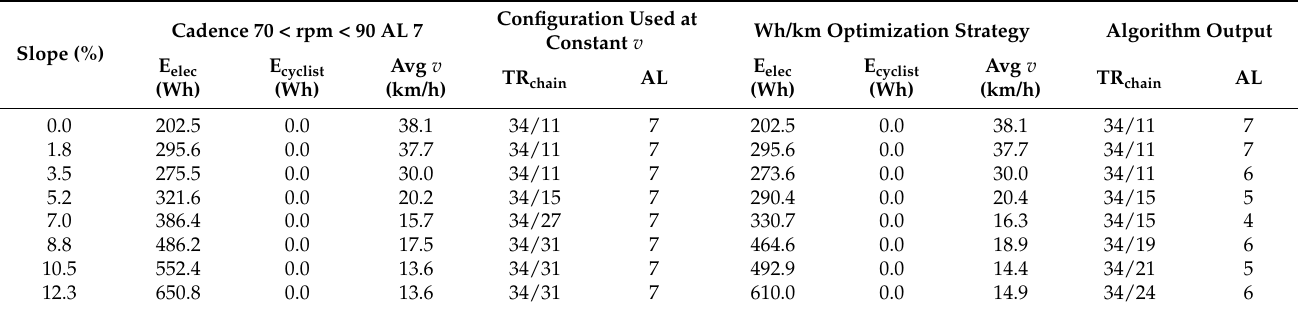
Table 7. Performance of strategies three and one under e-bike power alone (E stands for energy, v stands for speed, TR chain stands for chain transmission ratio and AL stands for assistance level).